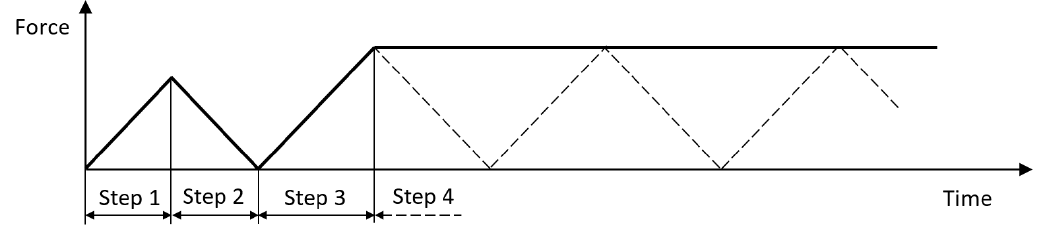
Figure 3. Outline of analysis